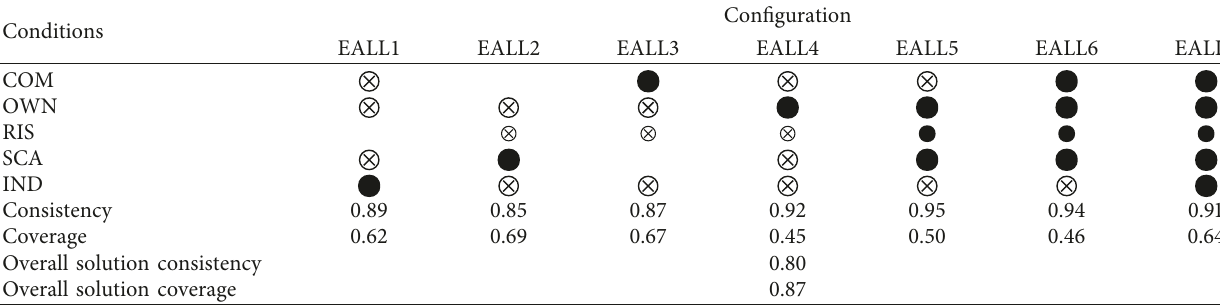
Table 6: The configuration of allocation